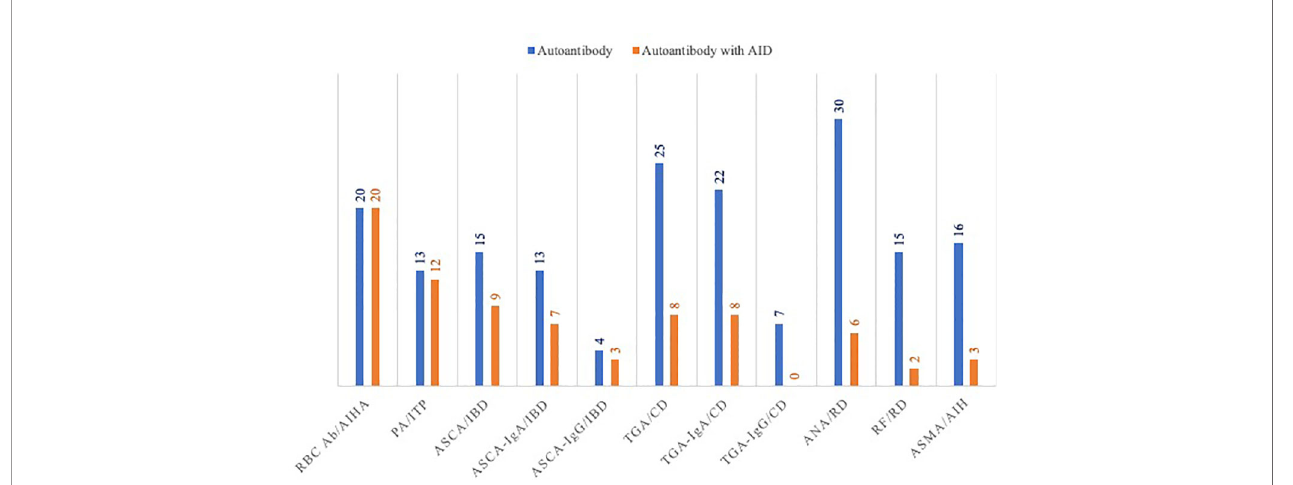
FIGURE 1 | Autoimmune diseases in patients with positive autoantibodies. AIHA, autoimmune hemolytic anemia; ANA, anti-nuclear antibodies; ASCA, anti- saccharomyces cerevisiae antibody; ASMA, anti-smooth muscle antibody; CD, celiac disease; IBD: in fl ammatory bowel disease; PA, platelet-bound antibodies; RBC Ab, red blood cell antibodies; RD, rheumatoid disease; TGA, anti-transglutaminase